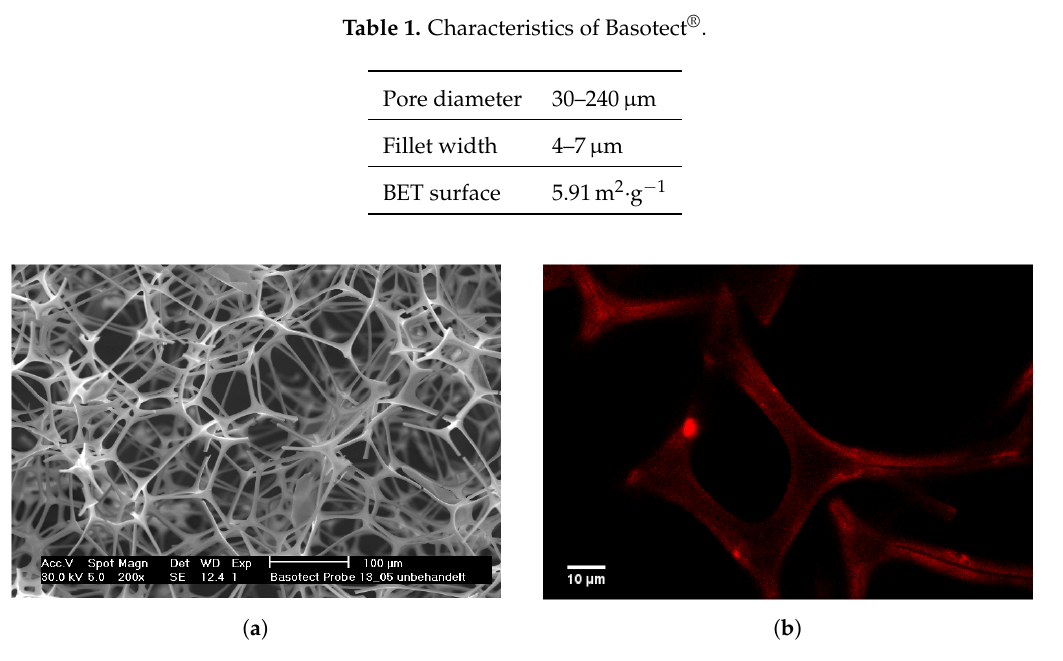
Figure 1. ( a ) Scanning electron microscopy view of pure Basotect ® ; ( b ) fluorescence microscopy of ATTO-TAG TM labeled amino functionalities on the Basotect ® surface after partial hydrolysis with concentrated HCl. The labeled sample was excited at 488 nm, and the emission was detected at 590